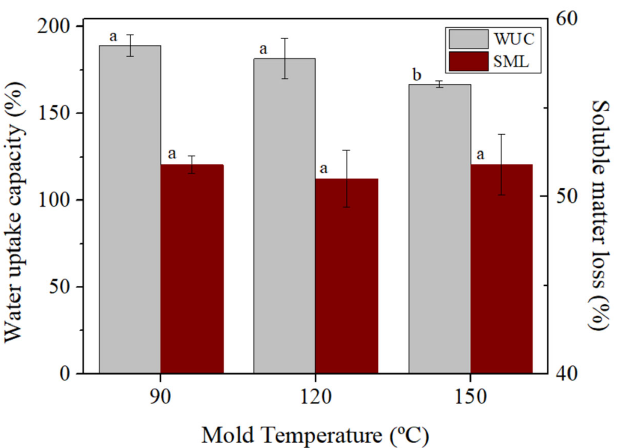
Figure 10. Water uptake capacity and soluble matter loss of the RO/Gly systems 70/30 at different molding temperature (90, 120 and 150 °C). Different letters (a, b) within the same column parameter (WUC or SML) indicate significant differences ( p < 0.05).